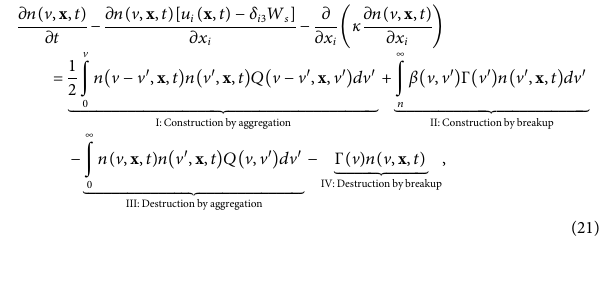
Frontiers in Earth Science |